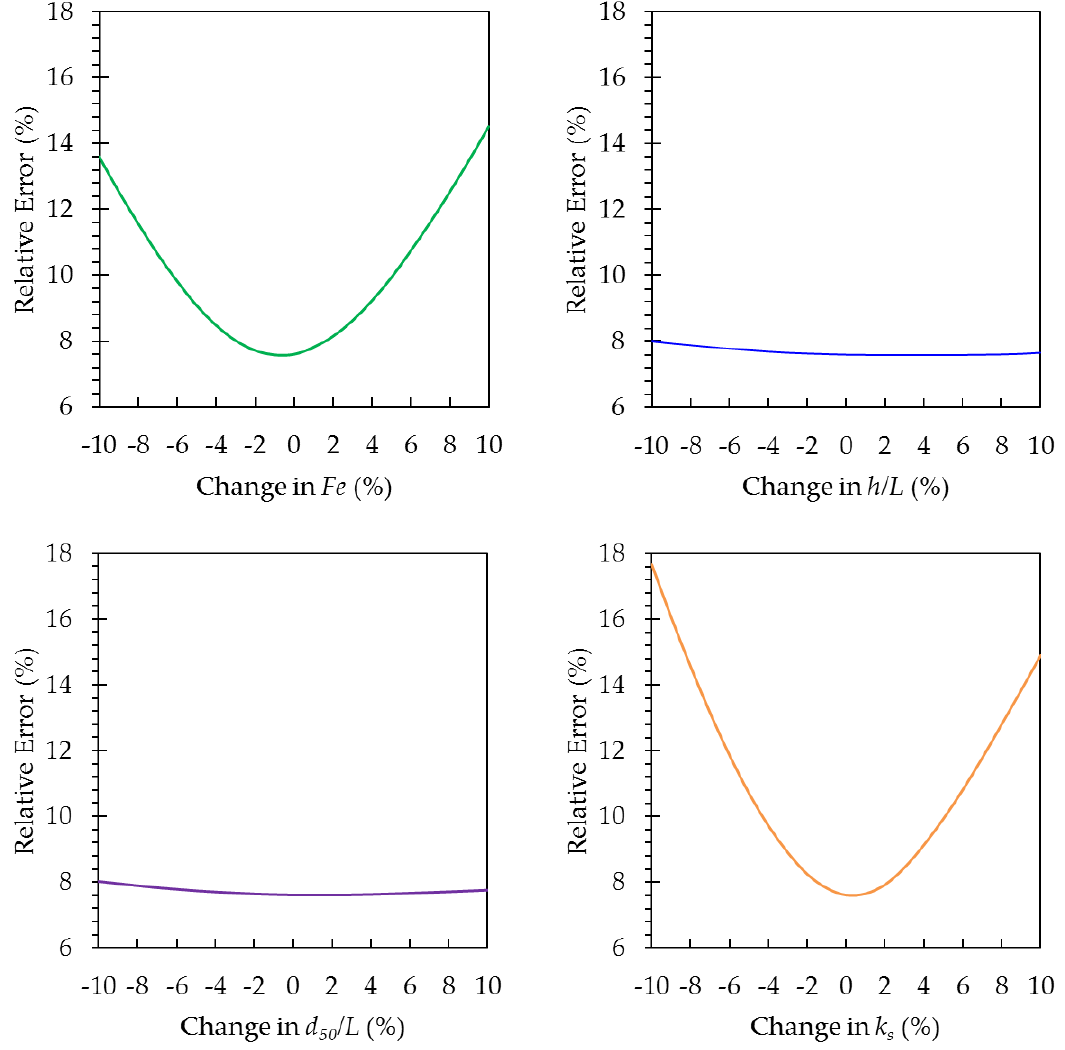
Figure 10. Alteration e ff ect of the input variables on the output mean absolute percentage error ( MAPE Figure 11. Alteration effect of the input variables on the output mean absolute percentage error ( MAPE )